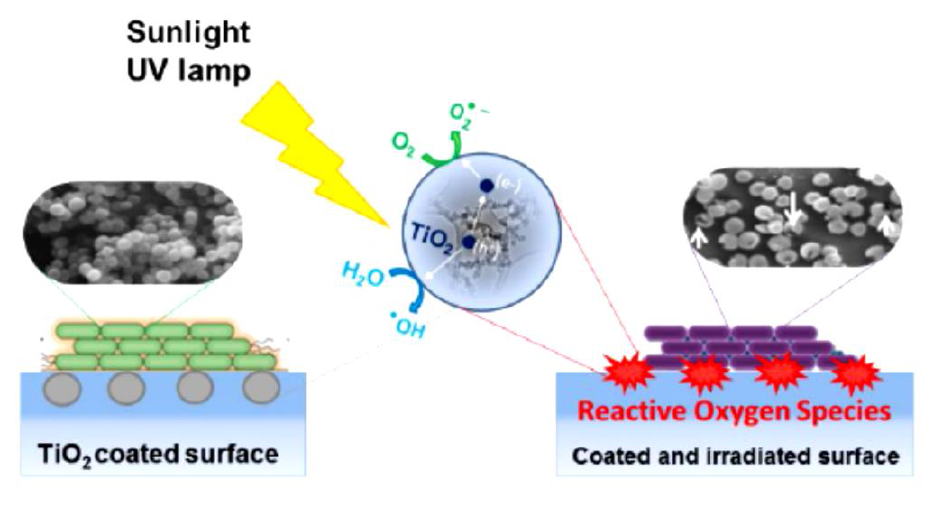
Figure 9. Schematic of self-disinfecting surfaces [67].